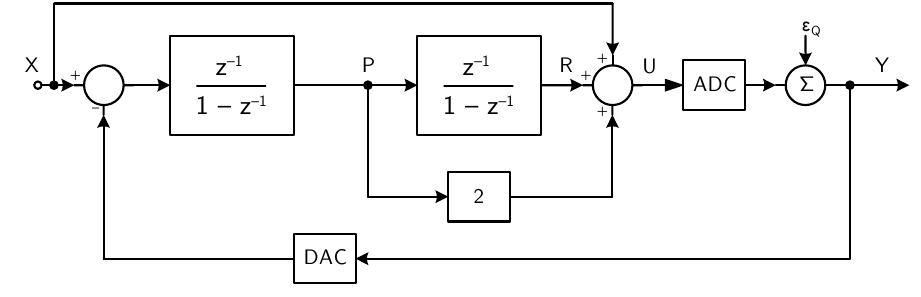
Figure 11. Block diagram of the DT analog second-order ΣΔ modulator (example 2).